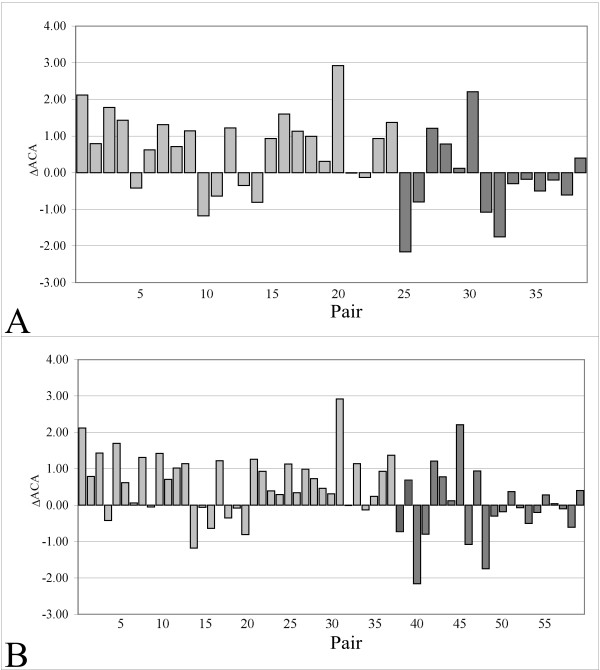
Differences in the apolar contact area (ΔACA) for each protein pair, composing dataset A and B, computed over the SCRs. Values for hyperthermophilic/mesophilic protein pairs and thermophilic/mesophilic pairs are expressed in Å2/residue and represented as light grey and dark grey bars, respectively. Numbers on X-axis refer to Table 1 (A) and Table 2 (B).